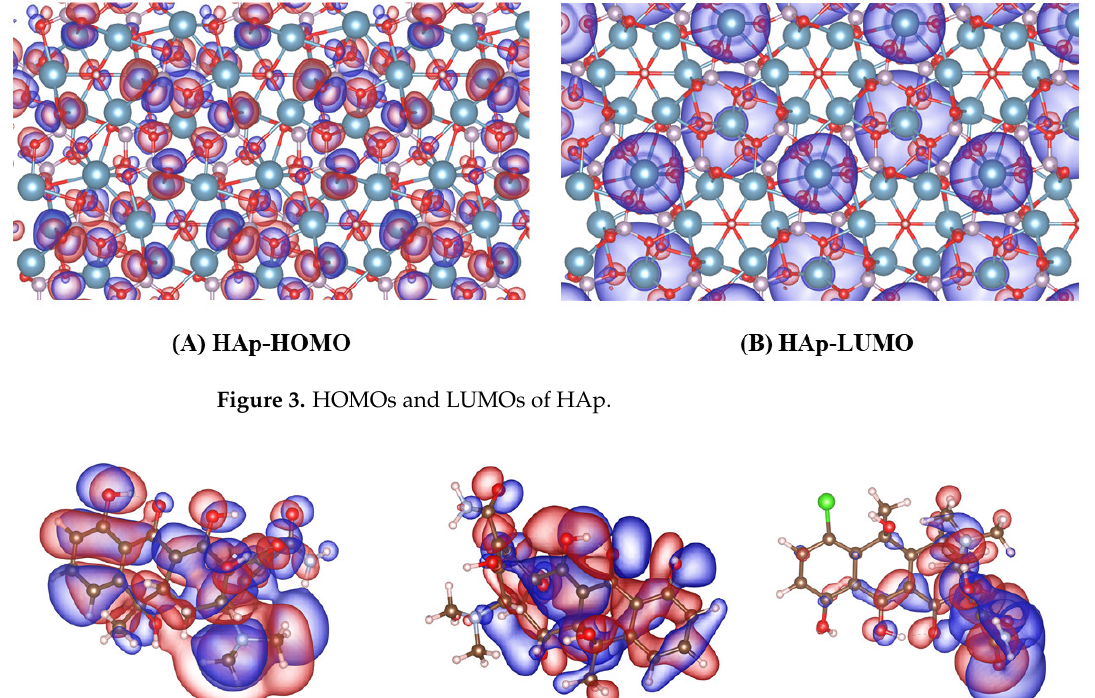
Table 1. Adsorption energy between TC, OTC, CTC, and HAp surfaces (Units: eV).